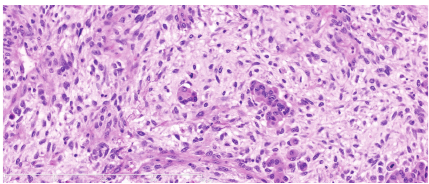
Figure 3: High power photomicrograph picture (Mag × 20) show- ing carcinoma with atypical glands and atypical stroma showing increased mitotic activity.